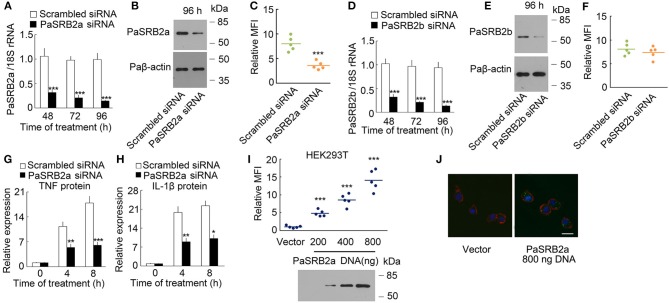
PaSRB2a mediated LPS internalization and pro-inflammatory response. (A) PaSRB2a mRNA levels in ayu macrophages treated with PaSRB2a siRNA. (B) PaSRB2a protein levels in ayu macrophages treated with PaSRB2a siRNA. Representative blots of three independent experiments are shown. (C) Effect of PaSRB2a siRNA on LPS internalization in ayu macrophages. (D) PaSRB2b mRNA levels in ayu macrophages treated with PaSRB2b siRNA. (E) PaSRB2b protein levels in ayu macrophages treated with PaSRB2b siRNA. Representative blots of three independent experiments are shown. (F) Effect of PaSRB2b siRNA on LPS internalization in ayu macrophages. (G) PaSRB2a effect on TNF expression in LPS-treated ayu macrophages. (H) PaSRB2a effect on IL-1β expression in LPS-treated ayu macrophages. (I) LPS internalization in HEK293T cells transfected with a PaSRB2a expression plasmid by flow cytometry. Representative blots of three independent experiments are shown. (J) Internalization of LPS in HEK293T was observed by confocal microscopy. Green color: FITC-LPS, red color: rhodamine-phalloidin, blue color: 4', 6'-diamidino-2-phenylindole (DAPI). Bar, 20 μm. Each bar represents the mean ± SE. n = 5. Data are representative of two (A,C,D,F–I) and three (B,E,J) independent experiments. *P < 0.05, **P < 0.01, ***P < 0.001.